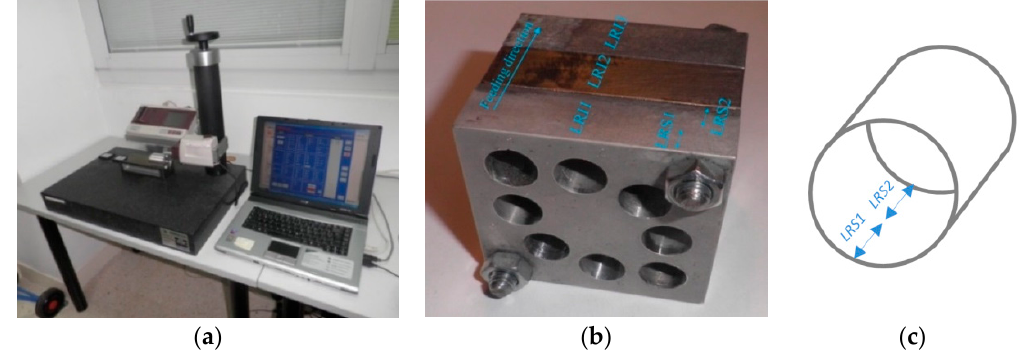
Figure 5. ( a ) Mitutoyo Surftest SJ 401 roughness tester; ( b ) location of the measurements of LRS and LRI along the feeding direction, inside each hole; and ( c ) detail of the specific measurement locations in the holes of each specimen.